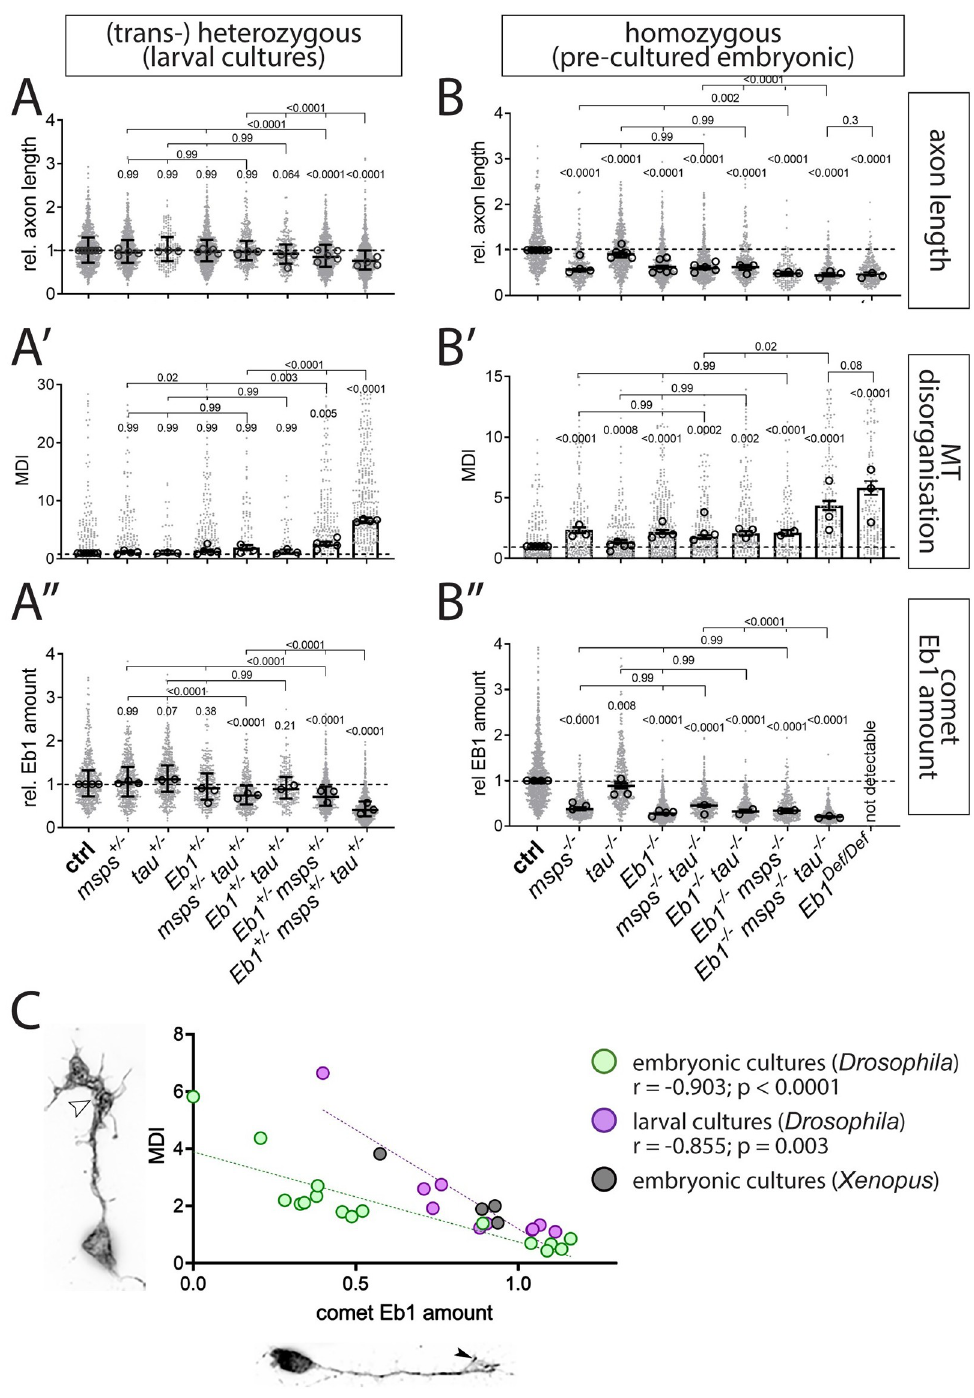
Fig 2. Eb1 , tau and msps interact genetically. A-B” ) Axon length, MT curling and Eb1 amount (as indicated on the right), for primary neurons displaying heterozygous (A-A”, larval cultures) and homozygous (B-B’, embryonic 6d pre- cultures’) mutant conditions, alone or in combination. Data were normalised to parallel controls (dashed horizontal lines) and are shown as scatter dot plots with median ± 95% confidence interval (A, A”,B, B”) or bar chart with mean ± SEM (A’, B’) of at least two independent repeats with 3 replicates each; large open circles in graphs indicate median/mean of independent biological repeats. P-values above data points/bars were obtained with Kruskall-Wallis ANOVA tests; used alleles: msps A , tau KO , Eb1 04524 . C ) The graph compares Eb1 amounts at MT plus-ends with the degree of MT curling (MT disorganisation index/MDI) for a range of genetic conditions used in this work: green dots show data from pre-cultured embryonic neurons (B’ vs. B”), purple dots show comparable data obtained from larval primary neurons (A’ vs. A”);